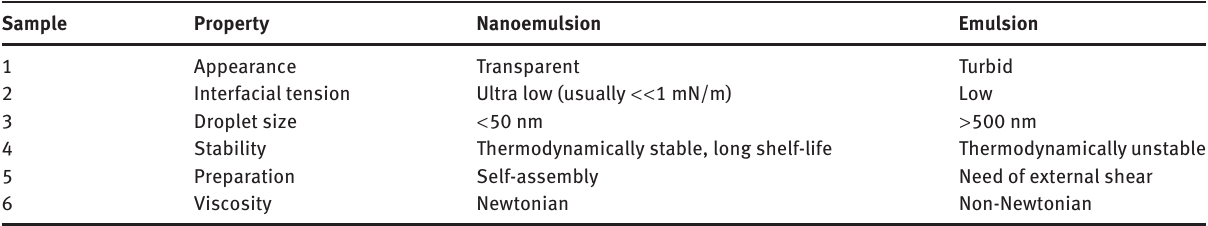
Table 2 Comparison of nanoemulsion fluids and